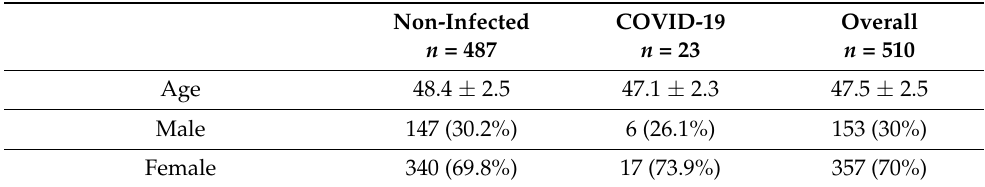
Table 1. Demographical, clinical, and adverse events data of study